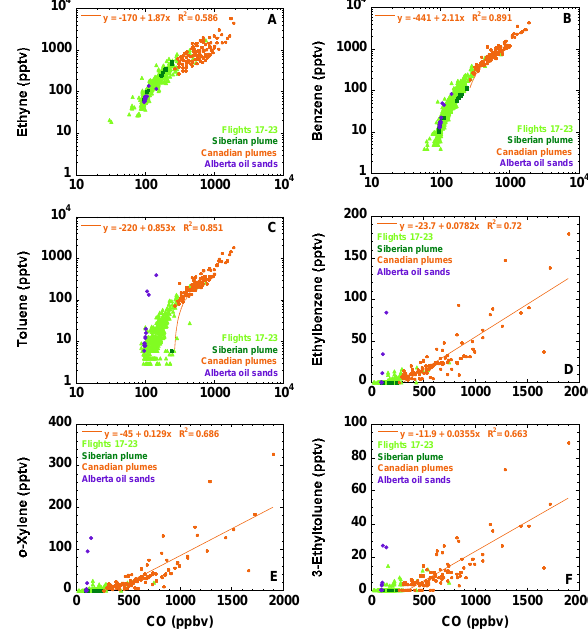
Figure 6. As in Figure 4 but for selected alkenes. Fig. 6. As in Fig. 4 but for selected alkenes. Figure 7. As in Figure 4 but for ethyne and selected aromatics. Fig. 7. As in Fig. 4 but for ethyne and selected aromatics.